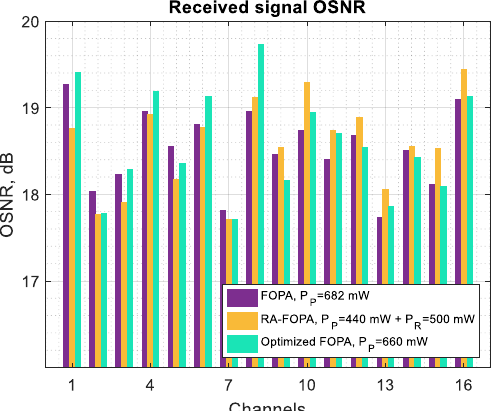
Figure 6. All 16 WDM channel optical signal to noise ratio (OSNR) distribution in the case of FOPA, RA-FOPA and peak-gain-optimized FOPA. OSNR values are calculated from received signal BER at equalized received signal power level (−21.7 dBm).